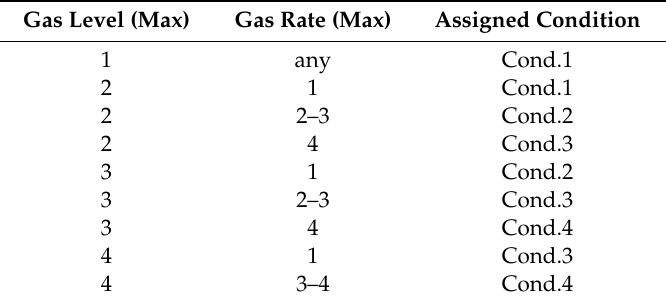
Table 11. Assigned condition based on gas level and gas rate.